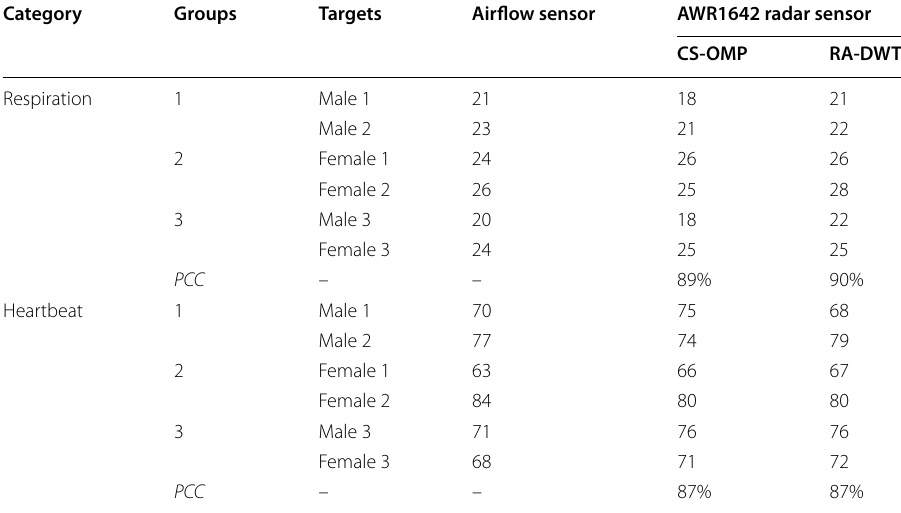
Table 2 Comparison of the respiration and heartbeat rates between two targets Category Groups Targets